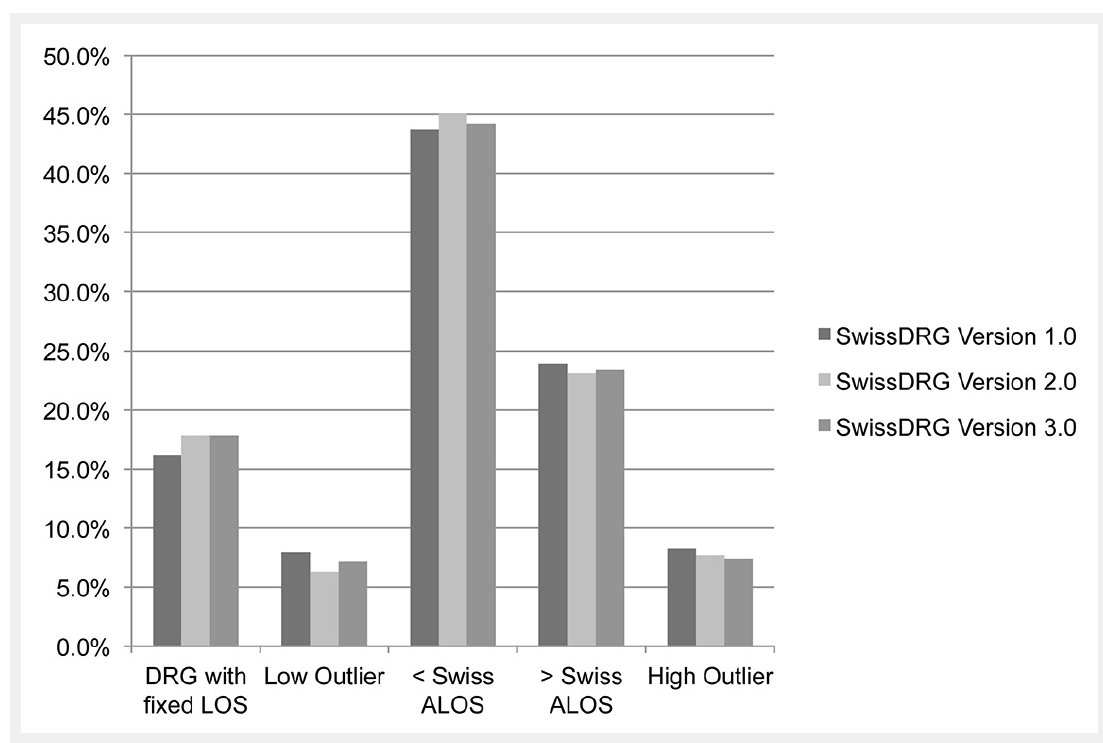
Figure 2 Proportions of DRG inliers (< Swiss ALOS and > Swiss ALOS), DRGs with fixed LOS and outliers (low and high outlier) according to length of stay and definition of low and high trim points for outlier under SwissDRG Versions 1.0, 2.0 and 3.0 respectively. ALOS = average length of stay; LOS = length of